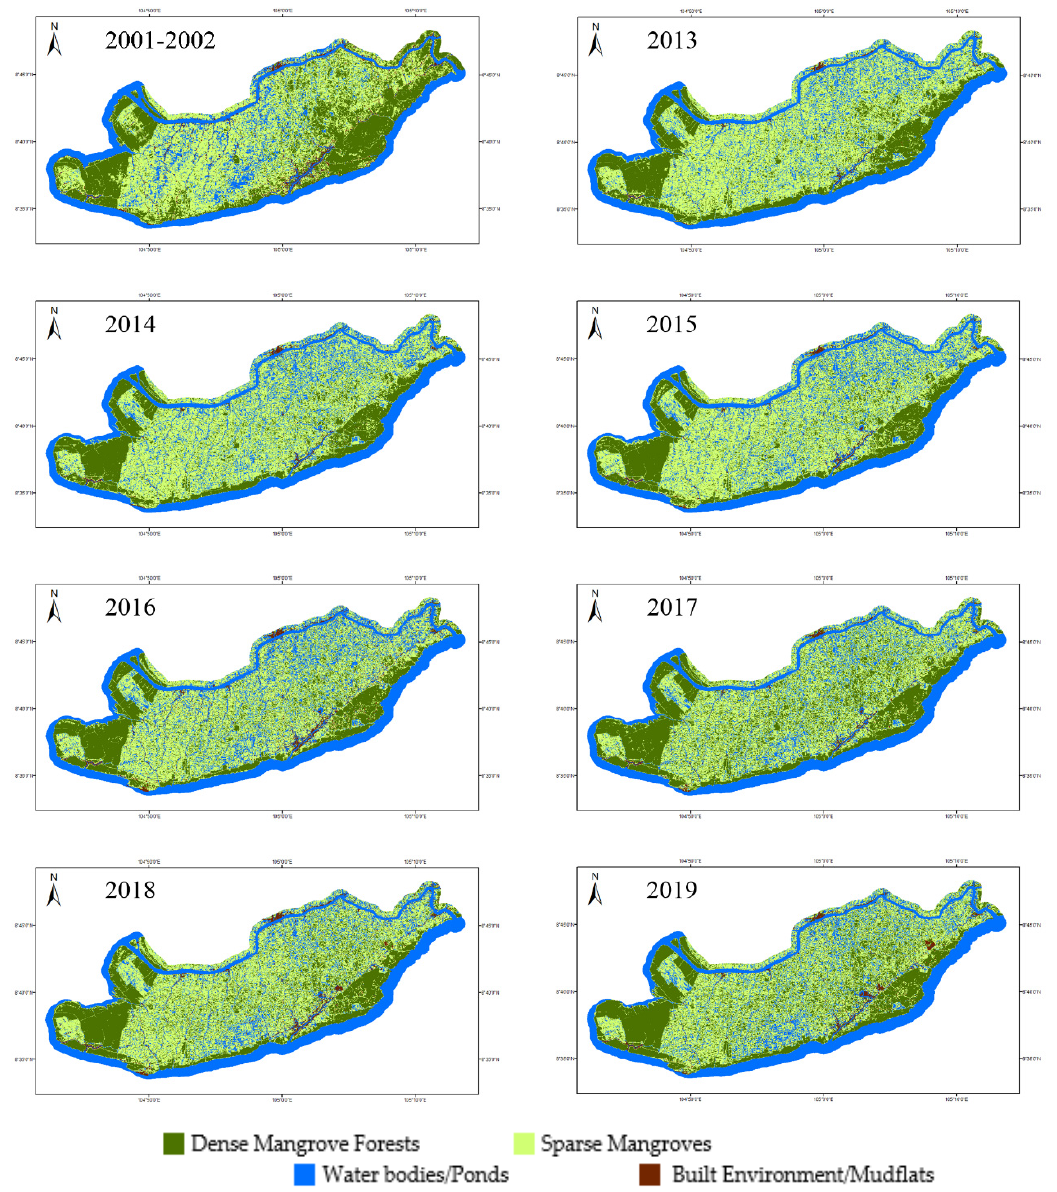
Figure 3. Time series of land use maps of Ngoc Hien District from 2001–2002 and 2013–2019, displayed are all years with full data availability (non-SLC malfunction).